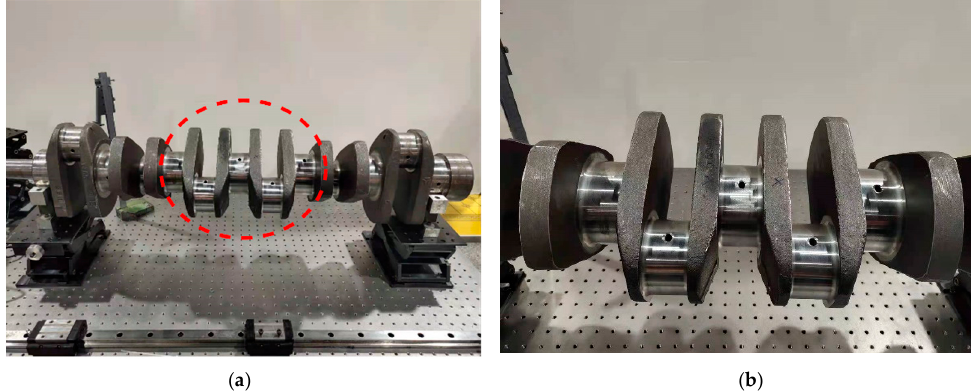
Figure 7. Heavy-duty truck engine 6-cylinder crankshaft. ( a ) Image of the whole crankshaft. ( b ) Image of partial crankshaft.